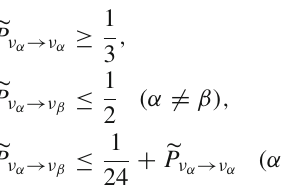
with (cid:18)δ = δ 3 − δ 2 . The effective rotation angle θ eff is given